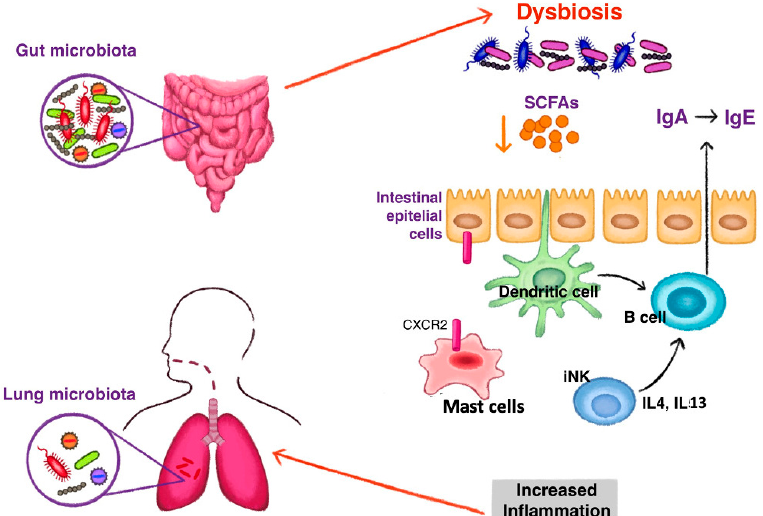
Figure 1. The mechanism of gut dysbiosis leading to the development of type 2 inflammation in asthma. Reduction of short chain fatty acids (SCFAs) induce a class switching of immunoglobulin (Ig) with an increase of fecal IgE acting on dendritic cells. Switching to IgE production is also stimulated by high levels of interleukin (IL) 4 and IL 13, produced by invariant natural killer (iNK) cells under dysbiosis stimuli. Dysbiosis influences the homing of mast cells to the intestine by the expression of CXCR2. Fewer intestinal mast cells and increased blood levels stimulate an inflammatory state observed in asthma.